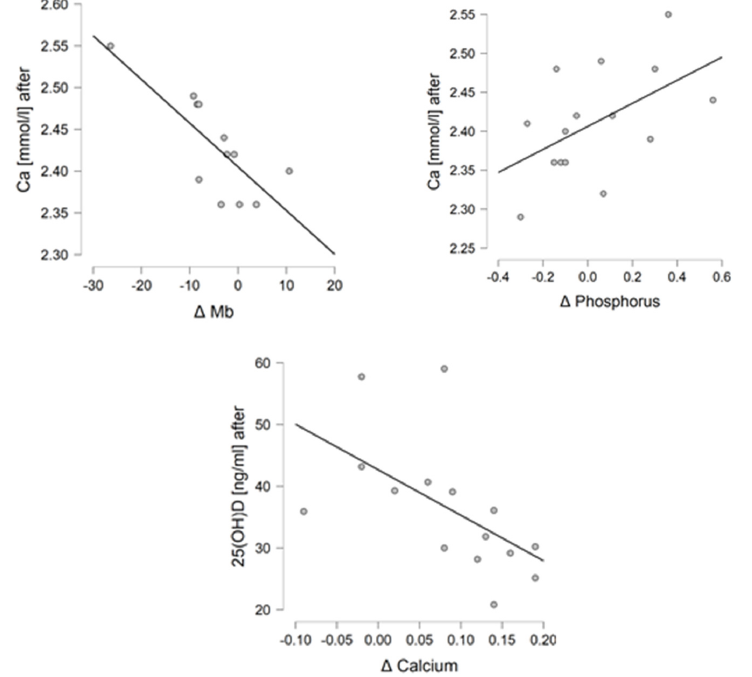
Figure 2. Correlations of statistically significant biochemical indices in the NW group.